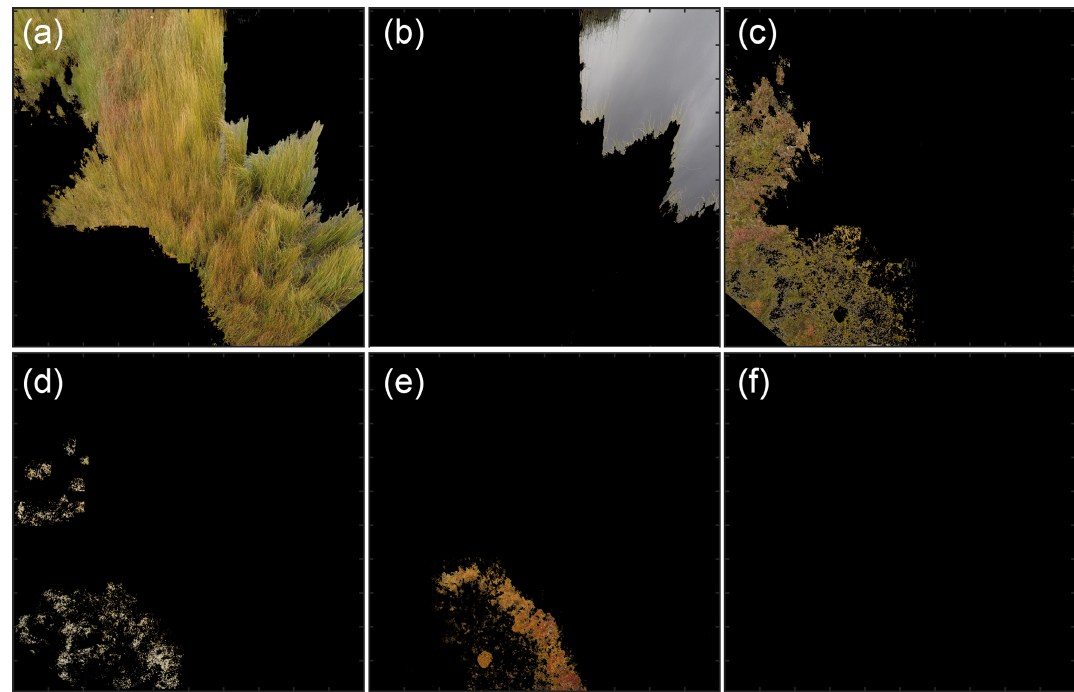
Figure 8. Classification of a field plot image (Fig. 6b) into the six main surface components. All panels have an area of 10 × 10m. (a) Graminoids, (b) water, (c) shrubs, (d) dry moss, (e) wet moss, (f)